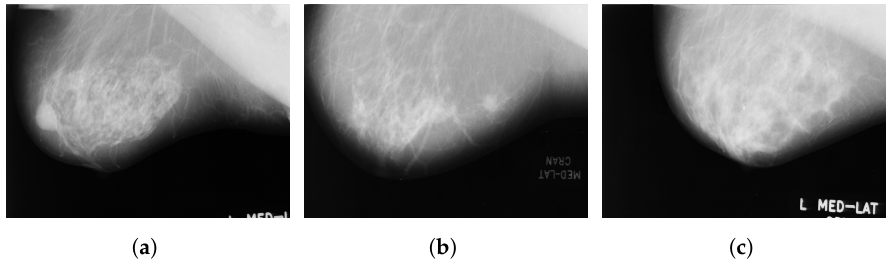
Figure 2. Sample images from the MIAS database ( a ): benign; ( b ): malignant; ( c ):